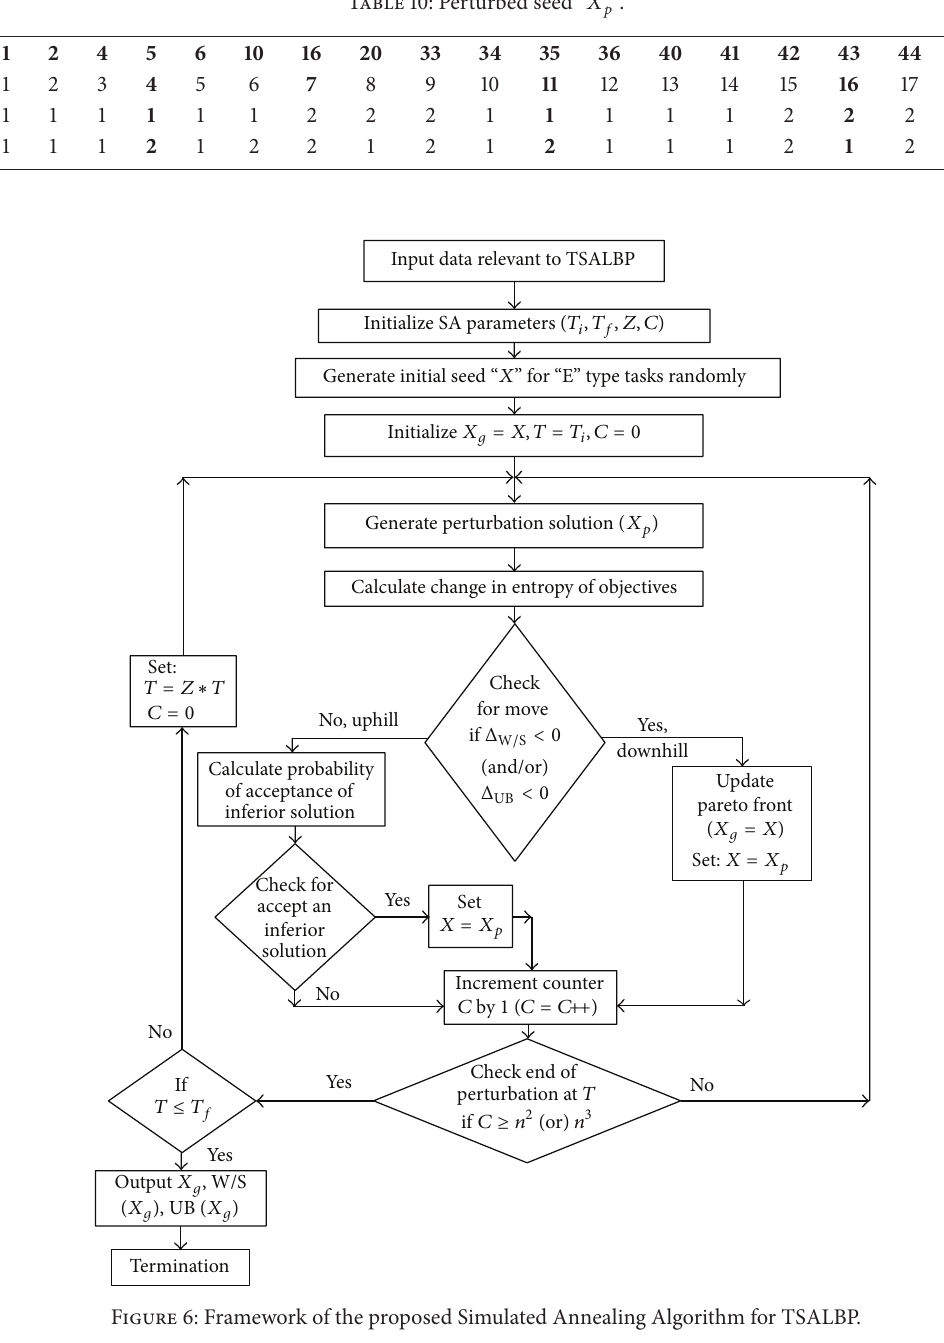
Table 10: Perturbed seed “ 𝑋 𝑝 ”.